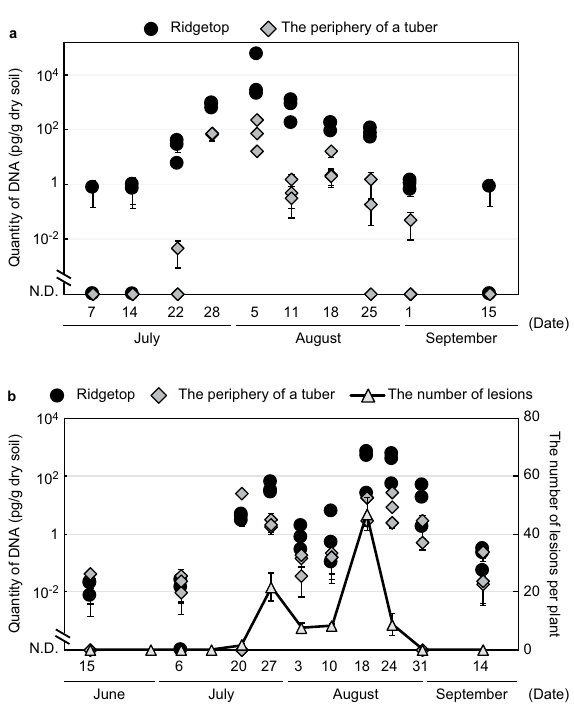
Figure 4. Changes in the quantities of P. infestans DNA and the number of foliage lesions. N.D. means not detected. Bars indicate the standard error. ( a ) 2017 results. ( b ) 2018 results.